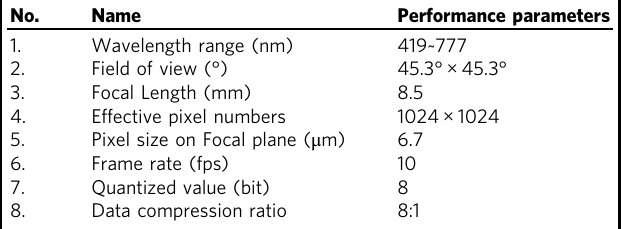
Table 2 The performance parameters of the